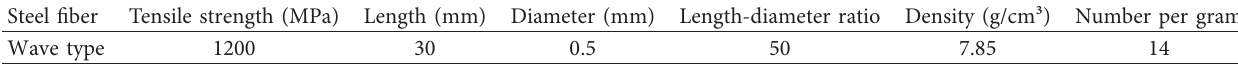
Table 3: Parameters of steel fiber.